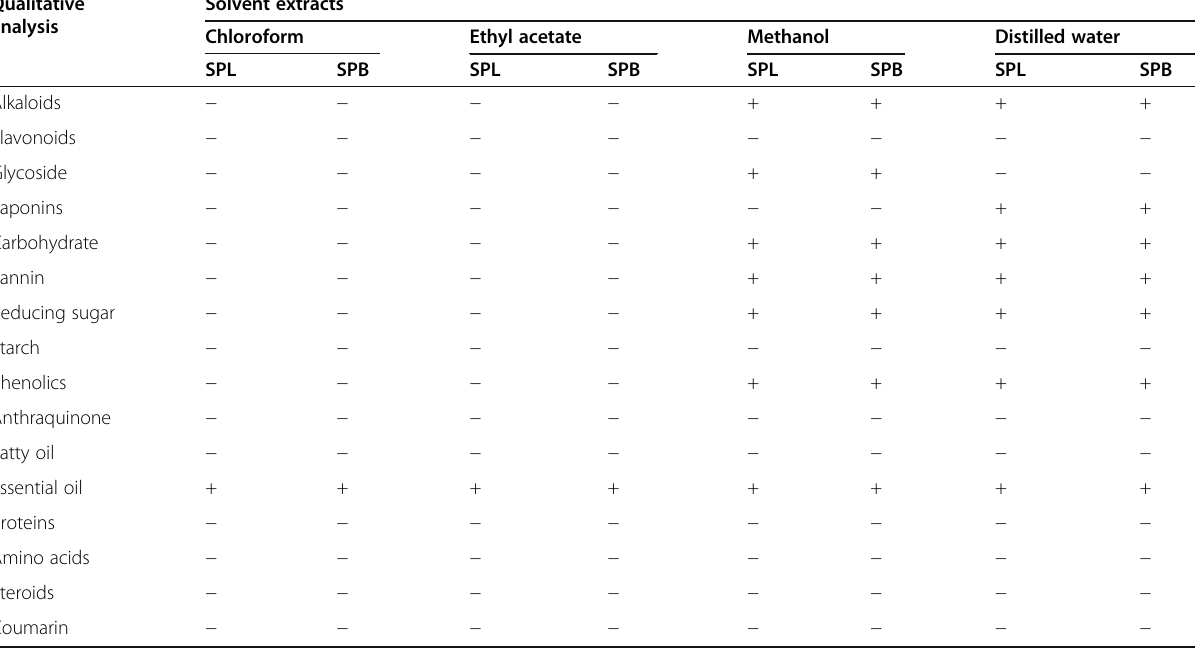
Table 4 Phytoconstituents present in the different solvent extracts of S . palghatense leaves and bark Qualitative analysis